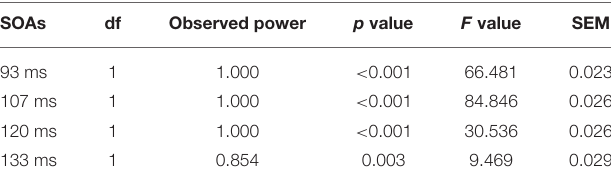
TABLE 4 | Pairwise comparisons of amplitude ratio (A2s/A1) between MDD and control groups with post-hoc t -tests (Bonferroni correction). SOAs